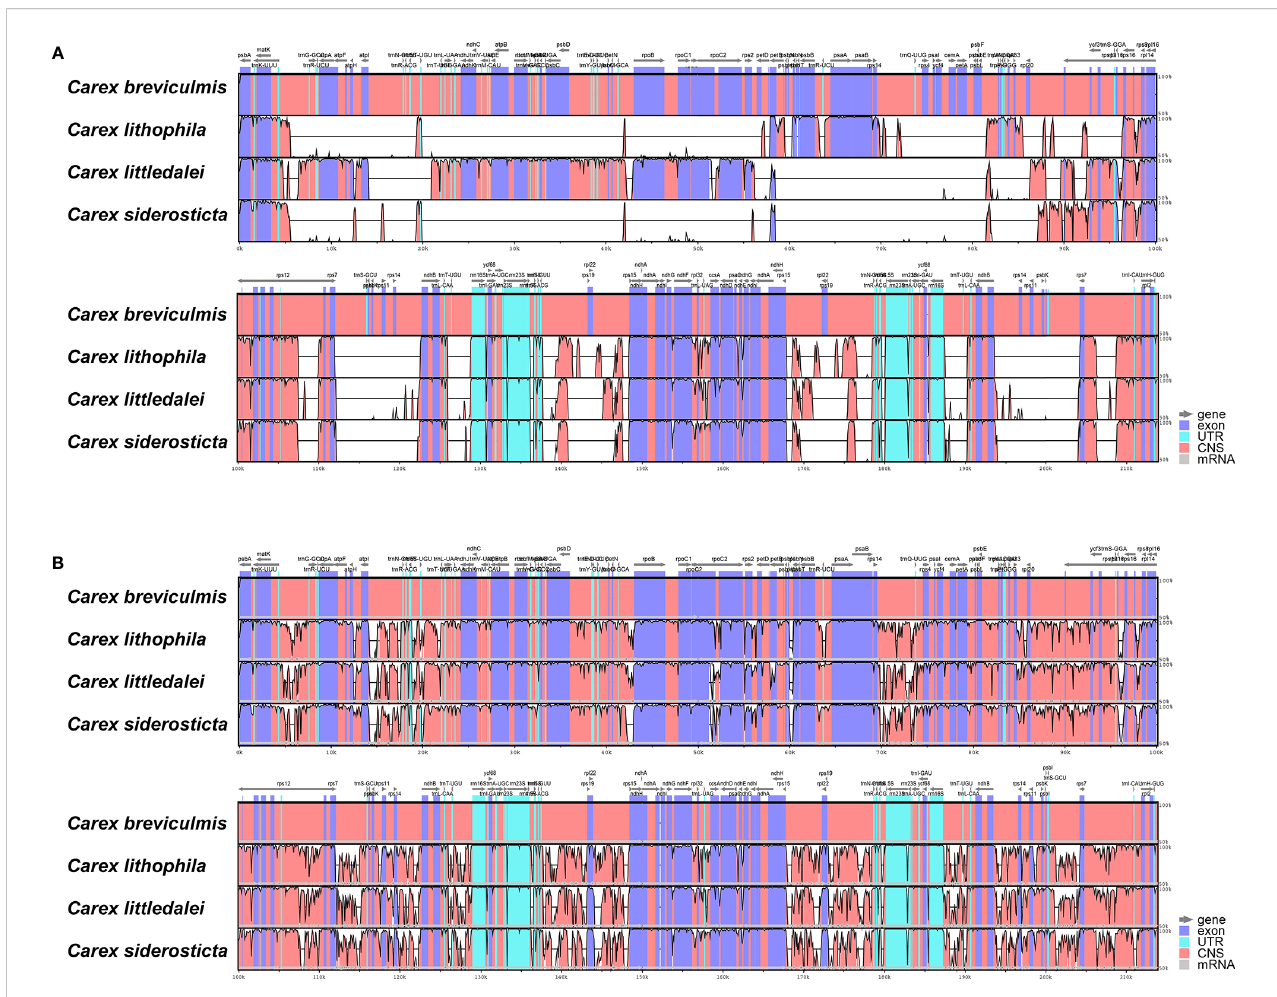
FIGURE 4 Sequencealignment offour Carex speciesusingthe programmVISTA. Acut-off value of 70%similarity wasused fortheplot,andtheYscaleindicatesthepercent similarity between50and100%.Bluerepresentscodingregionsand pinkrepresentsnon-codingregions. (A) LAGANmethod; (B) Shuf fl e LAGANmethod.